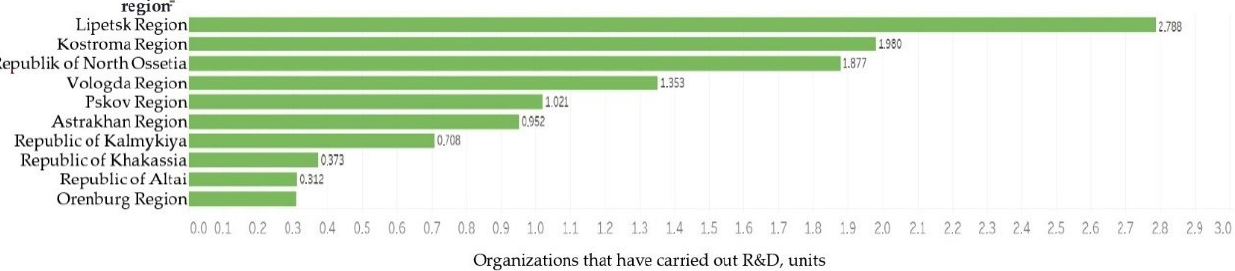
Figure 6. Size of incoming slacks by the indicator organisations engaged in R&D